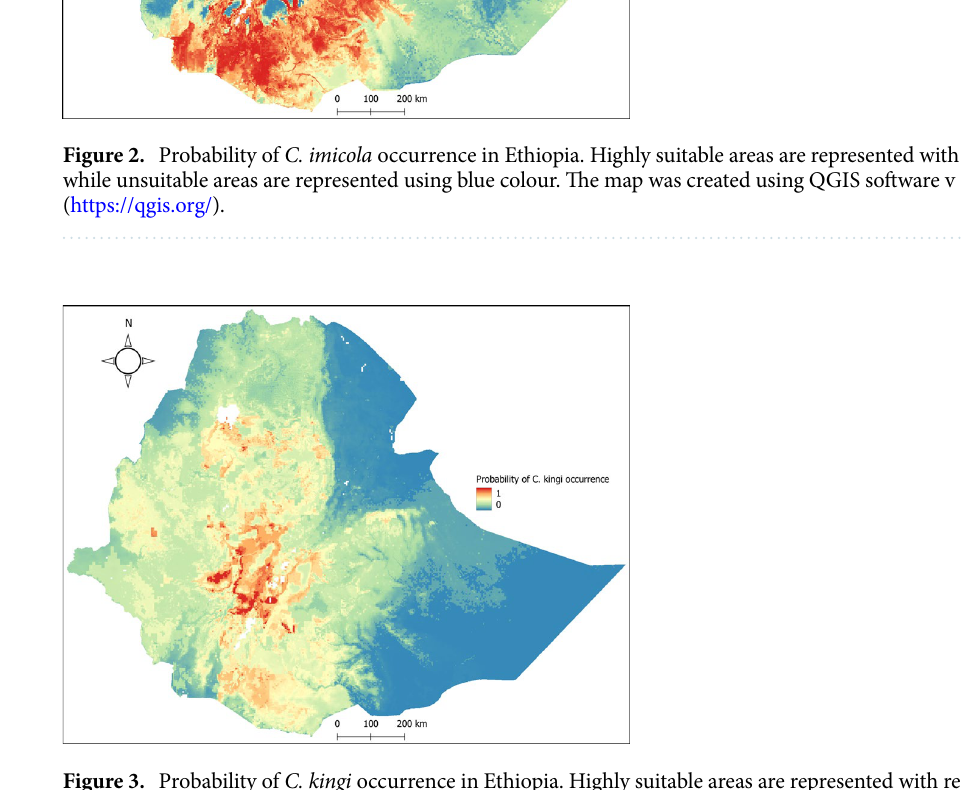
Figure 3. Probability of C. kingi occurrence in Ethiopia. Highly suitable areas are represented with red color while unsuitable areas are represented using blue color. The map was created using QGIS software v 3.22.2 (https:// qgis.